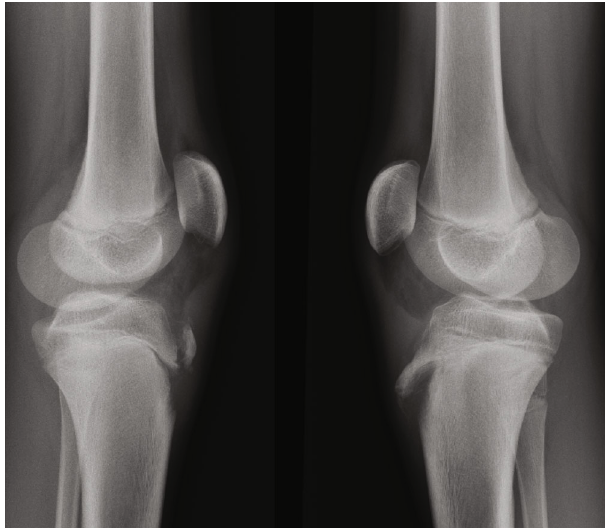
Figure 3: Case II: X-ray imaging asymmetrical avulsion fractures with a type IIA of the right knee and type II B of the left, again without intra-articular involvement.